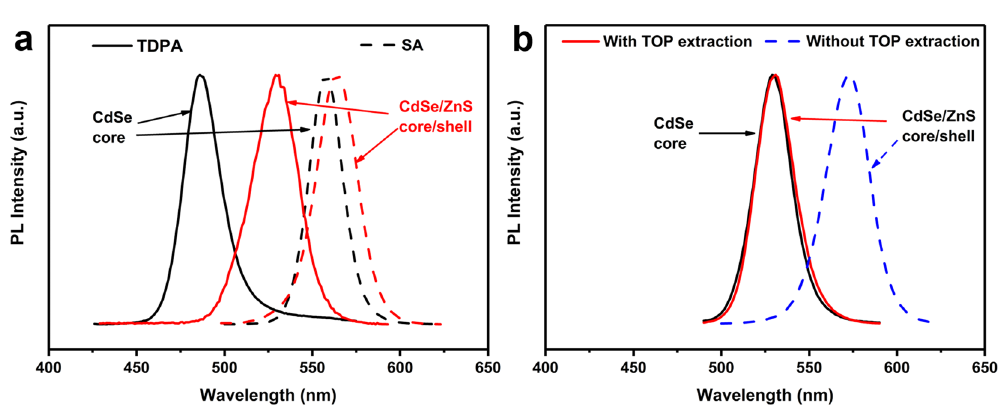
Figure 5. ( a ) Normalized PL spectra of CdSe/ZnS(3) core/shell QDs synthesized by different precursors, using Cd(TDPA) 2 (solid line, inadequate reaction) and cadmium stearate (Cd(SA) 2 ) (dashed line, adequate reaction) as CdSe precursors; ( b ) Normalized PL spectra of QDs in different shell formation synthetic processes, CdSe/ ZnS(3) core/shell QDs synthesized by typical TOP-SILAR method based on the rapid cooling process core (black solid line), with TOP-assisted extraction purification process (red solid line), without TOP assisted extraction purification process (blue dashed